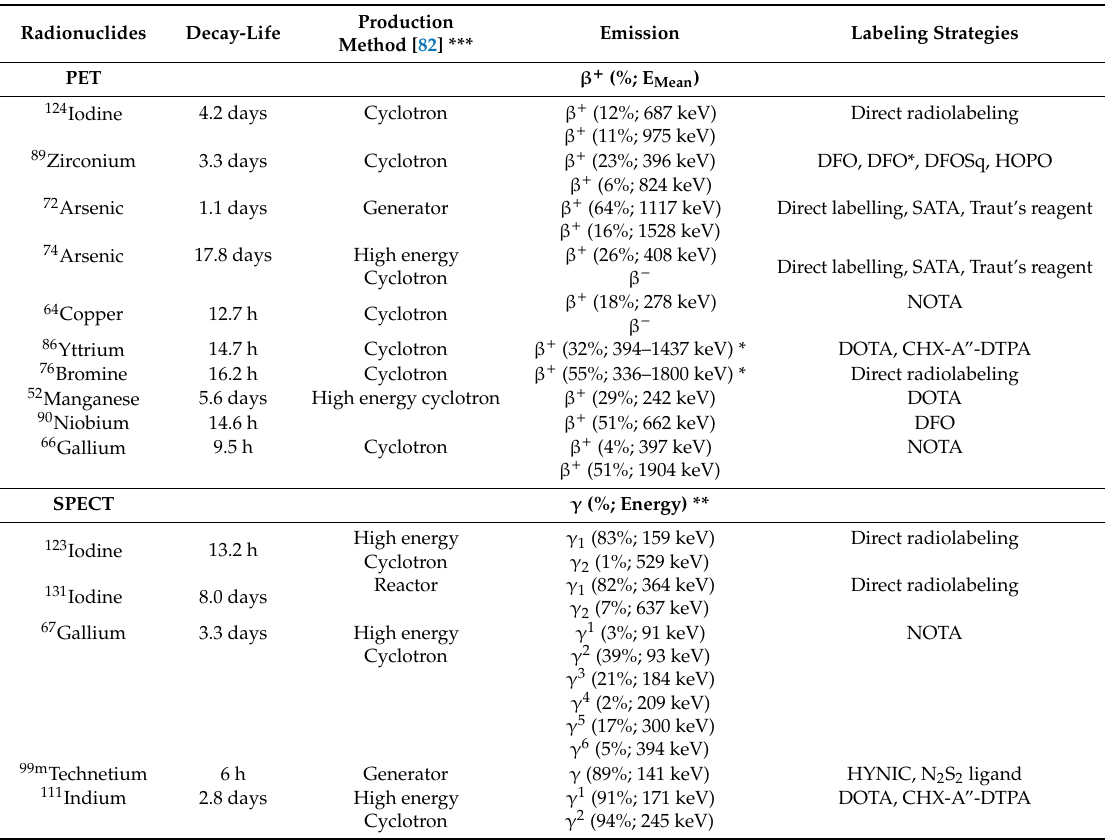
Table 1. Overview of radionuclides’ decay properties, emission and chelators for monoclonal antibody immuno-PET / SPECT imaging